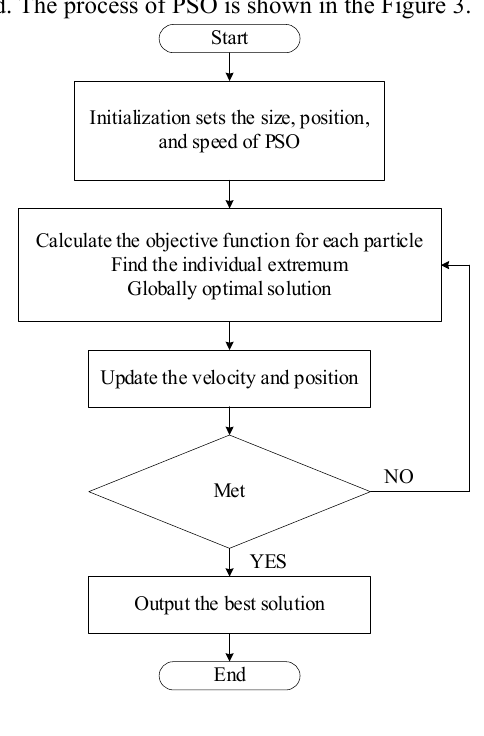
Figure 3. The process of particle swarm optimization